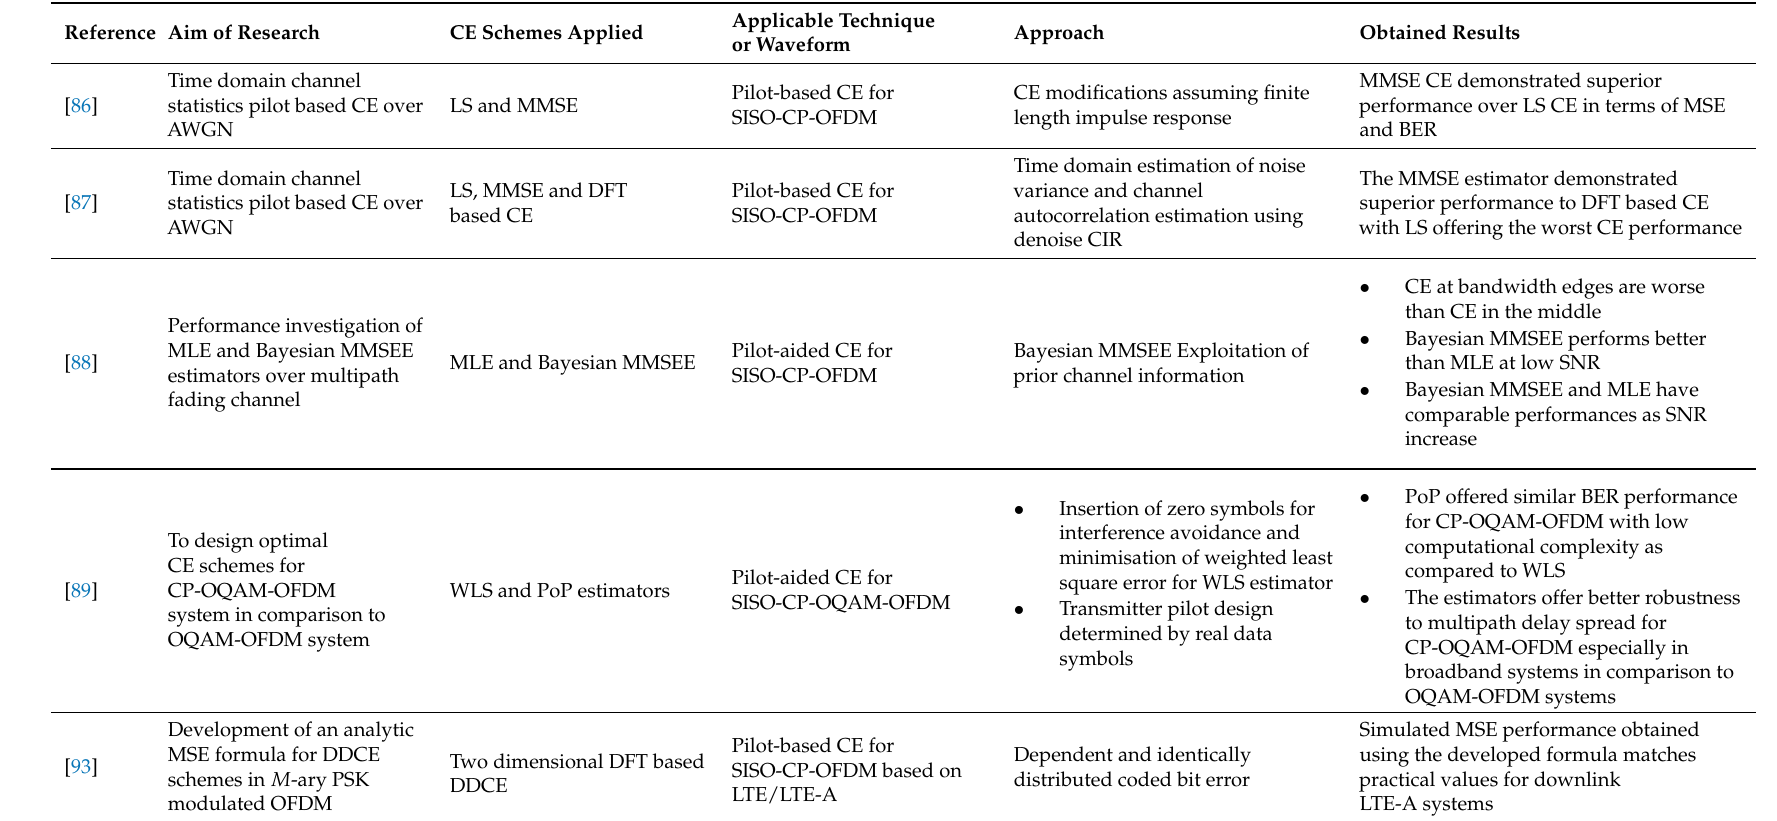
Table 3. Summary of CE techniques for non-filtered multicarrier modulation